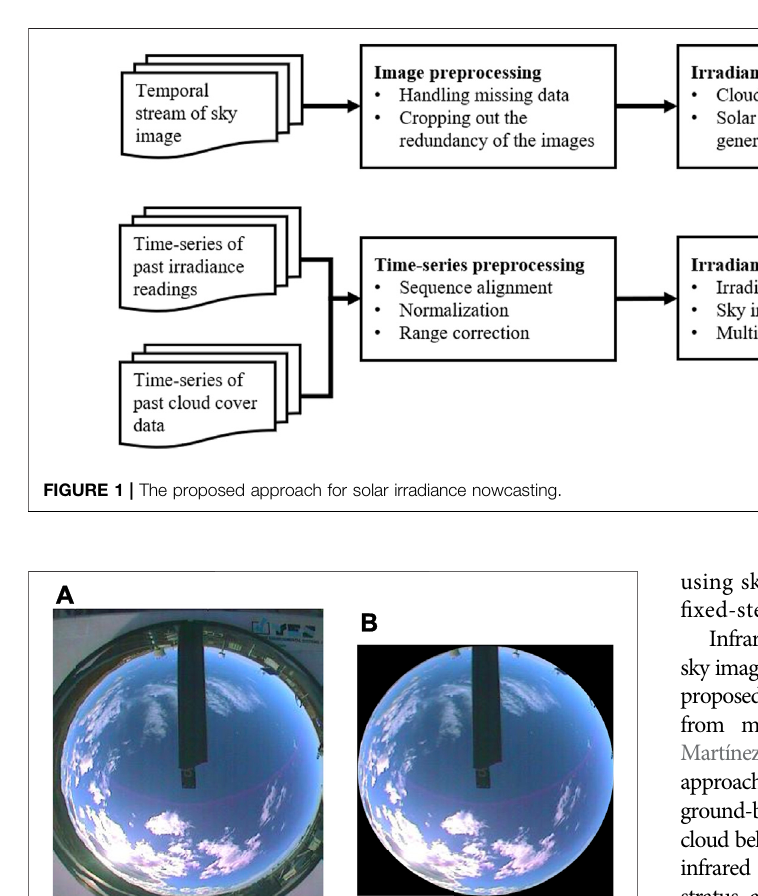
Frontiers in Energy Research |